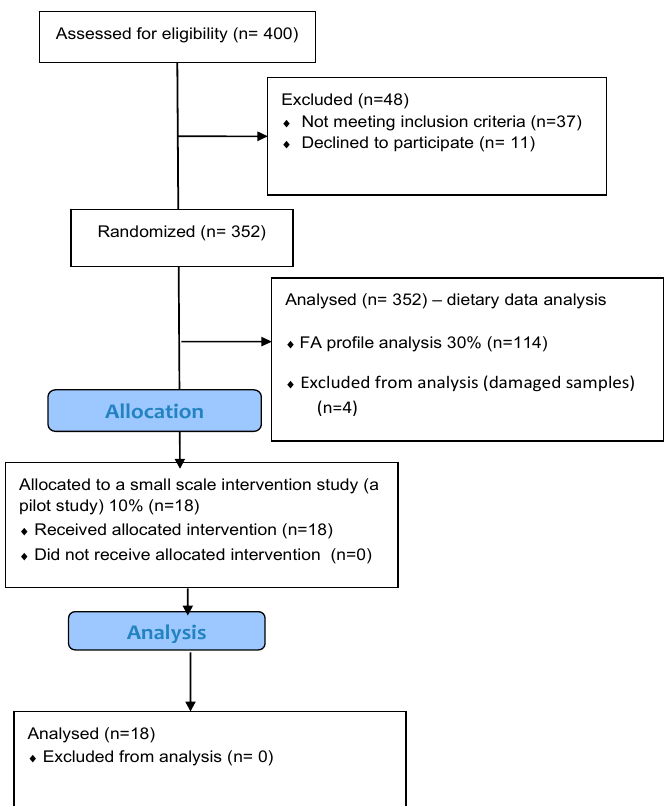
Figure 1. Flow chart indicating the number of participants.